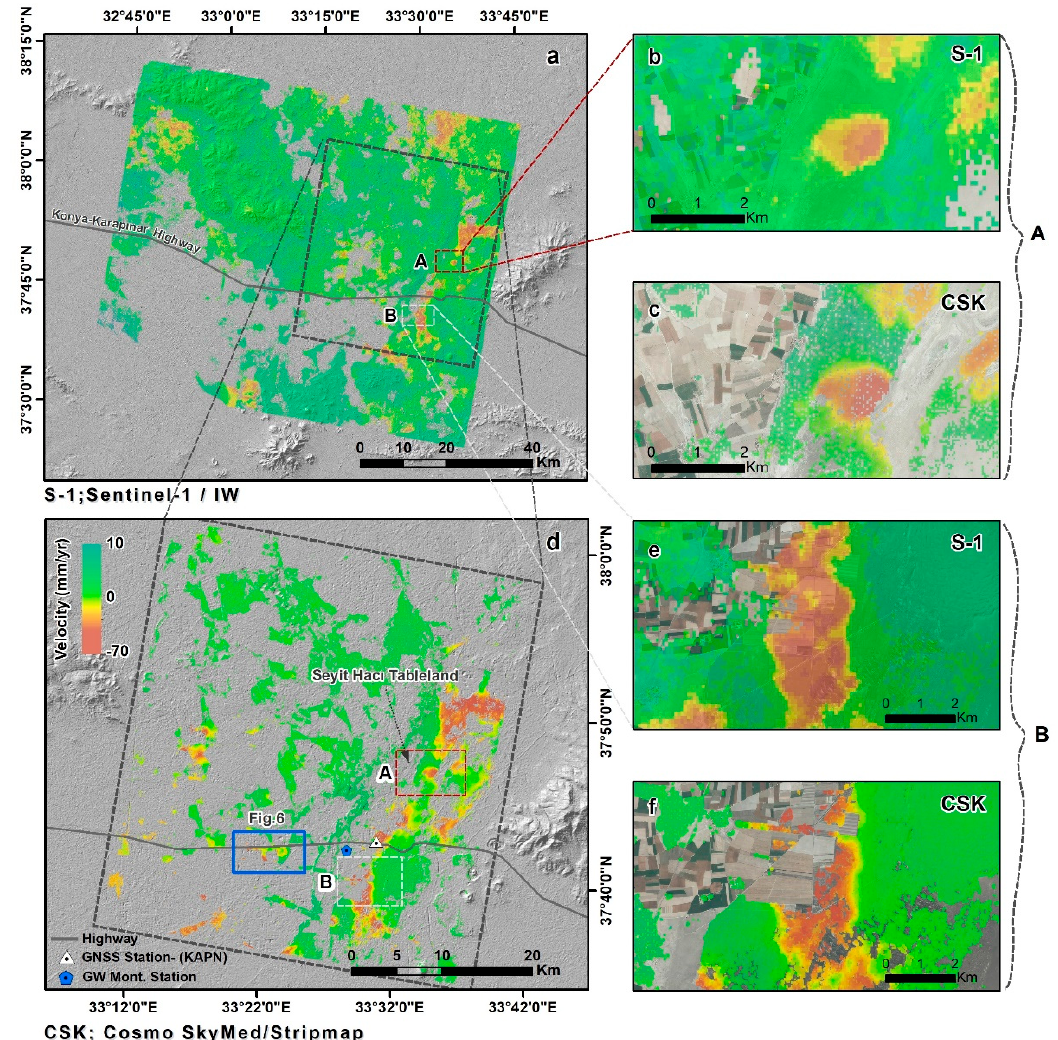
Figure 4. Velocity maps in line of sight (LOS) of the Karapınar study area derived from Sentinel-1 ( a , b , e ) and COSMO SkyMed ( d , c , f ) data. The velocity maps are laid over shaded relief maps derived from the SRTM dataset. The red and white dashed frames mark the locations of two zoom-in areas shown in ( b , c , e , f ). The triangle and blue pentagon mark the locations of the Global Navigation Satellite System (GNSS) stations and the groundwater well used in the study, respectively. Blue frames (in ( d )) mark the locations of Figures 6.